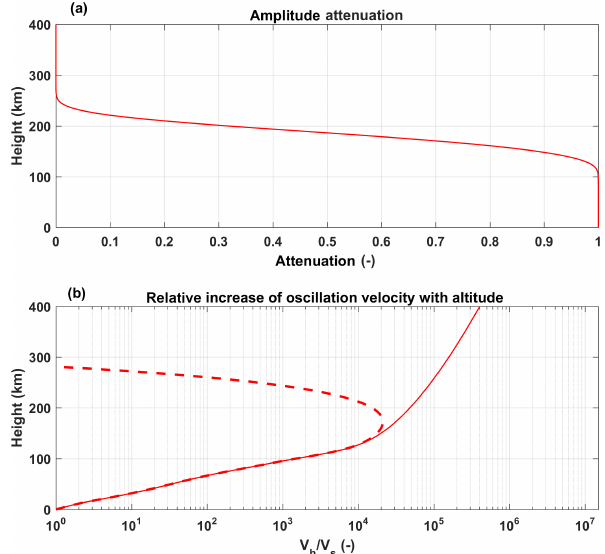
Figure 2. (a) Infrasound attenuation coefficient as a function height for 12.5s infrasound wavelength. (b) Ratio of infrasound oscilla- tion velocity at a particular height to that on the ground ( V h /V s ). The solid line indicates the infrasound oscillation velocity consid- ering only the amplification. The dashed line shows the combined effect of amplification and attenuation. The methodology utilized by Chum et al. (2012) has been utilized to calculate V h /V s